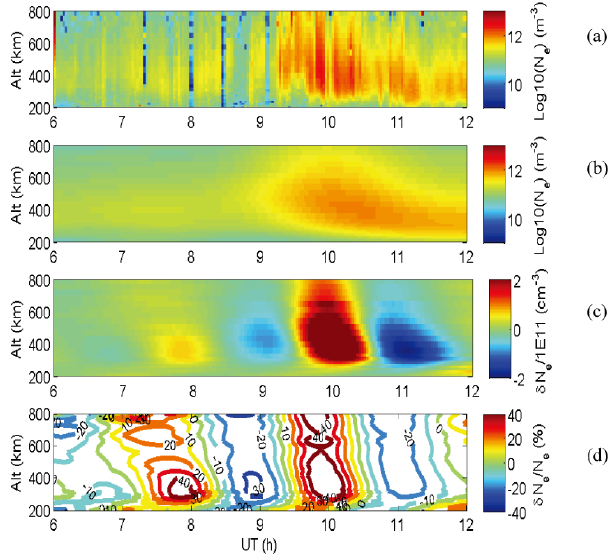
Fig. 2. From top to bottom, (a) overview of electron density ( N e ) observed by the fixed field-aligned 42m dish of ESR as a function of UT and altitude; (b) N e background by applying a zero-phase filter with a moving window of 2.5h; (c) electron density absolute disturbances, δN e by subtracting N e background from the observed density displayed in panel (a) ; and (d) fractional electron density fluctuations, δN e /N e (%) in relative to the background level dis- played in panel (b) .